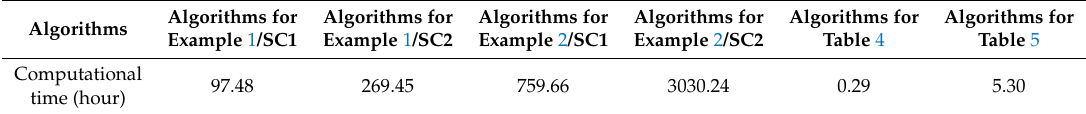
Table A1. Computational